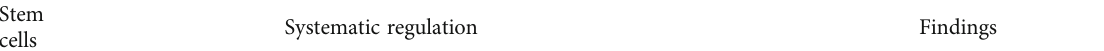
Table 3: Systematic regulation induces keratocyte di ff